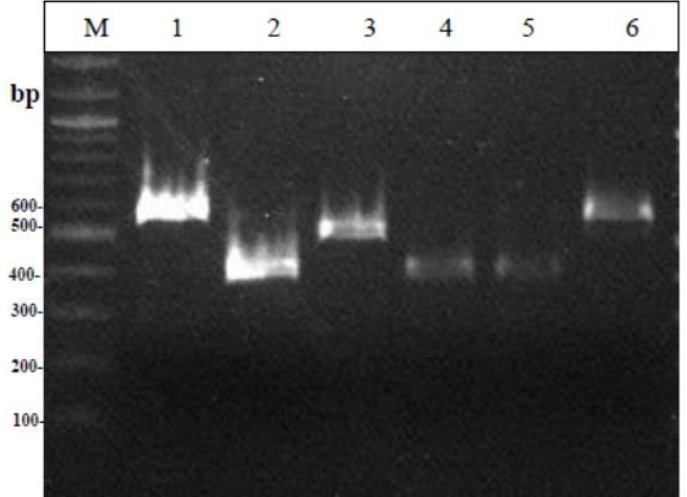
Figure 3. Results from the Multiplex PCR identifying the four genera Lactococcus, Lactobacillus, Streptococcus and LeuconostocM: 100 bp DNA ladder, 1: Leuconostoc pseudomesenteroides DSM 20193, 2: Lactococcus garvieae subsp. garvieae DSM 20684, 3: Streptococcus thermophilus LMG 13565, 4: MRS-8, 5: MRS-9, 6: M17-6 .